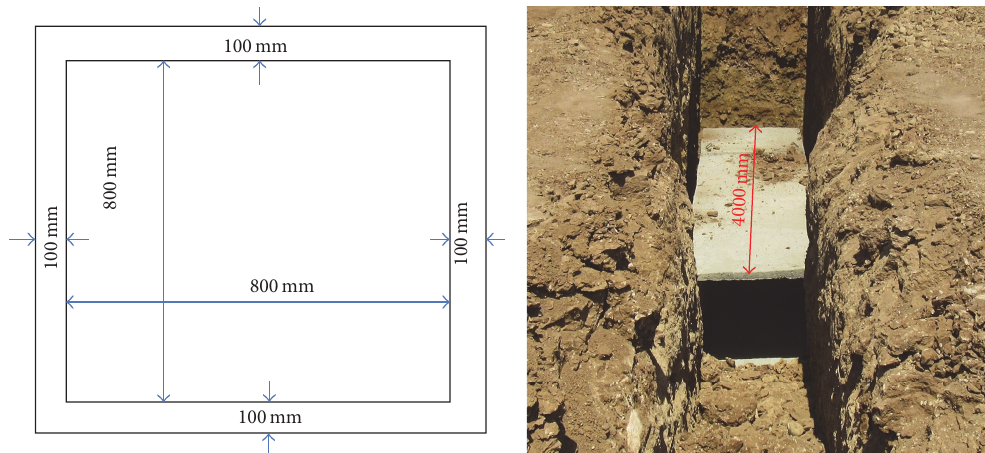
Figure 2: Cross section of the tunnel built for experiment.